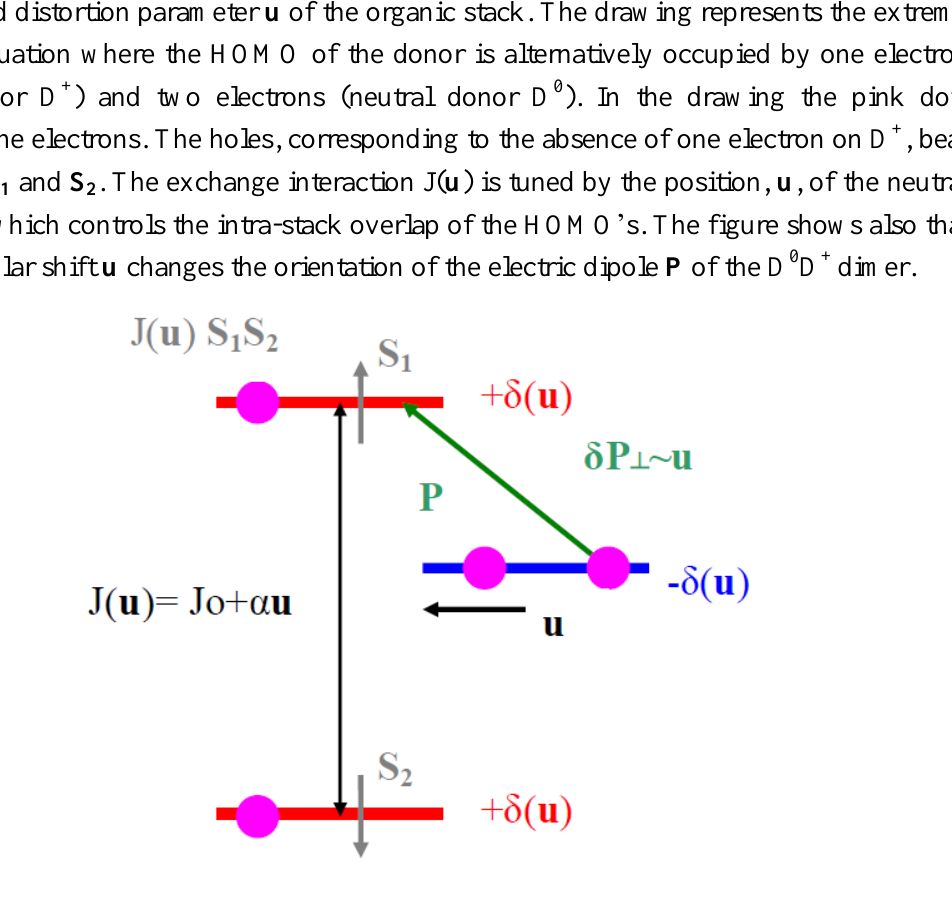
S function of a 1 2